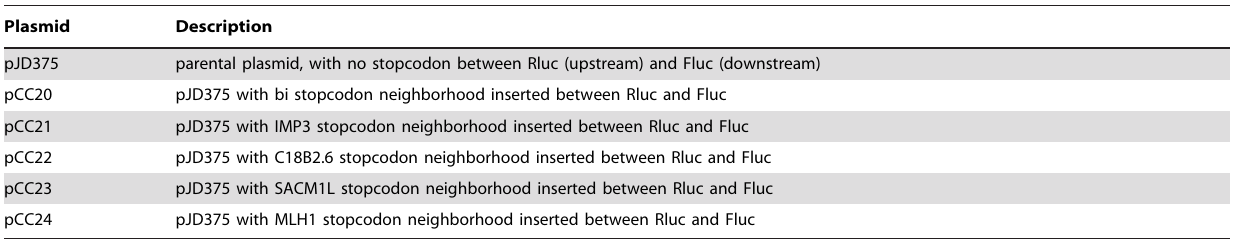
Table 3. Plasmid Strains.